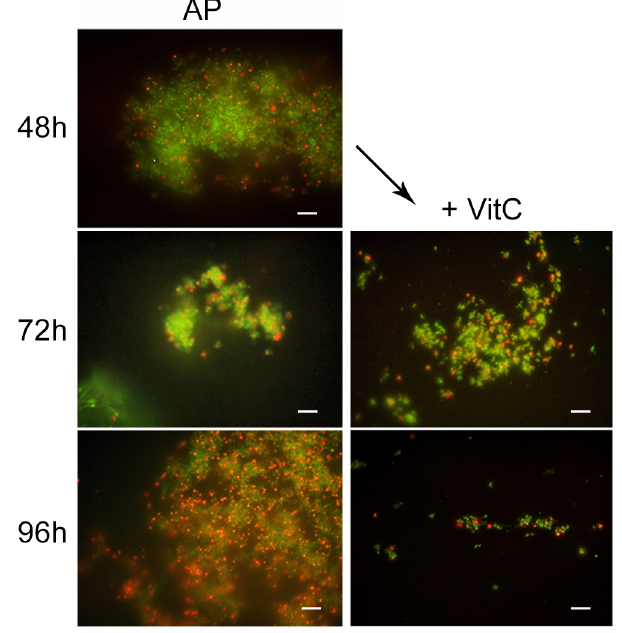
Figure 7. Representative images of Live/Dead staining showing the disaggregation action of VitC on AP cells, monitored after a further 24 h (72 h) and 48 h (96 h), compared to the untreated sample. Original magnification, 1000×.